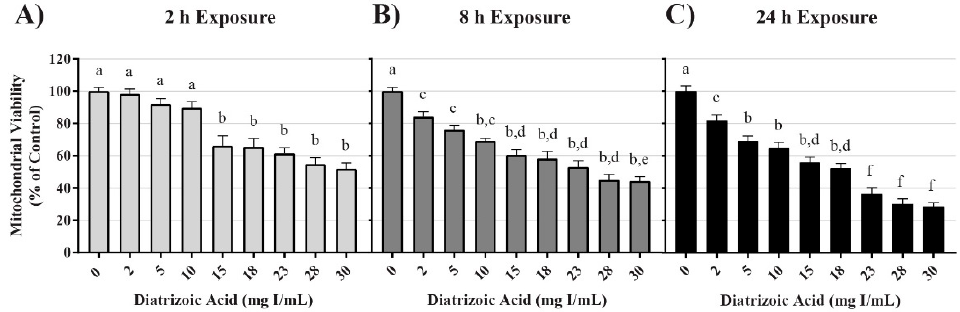
Figure 1. Diatrizoic acid cytotoxic effects on mitochondrial viability in HK-2 cells using 3-(4,5-dimethylthiazol-2-yl)-2,5-diphenyltetrazolium bromide (MTT). Diatrizoic acid (DA) diminished mitochondrial viability at 2 h ( A ), 8 h ( B ), and 24 h ( C ). Different letters (a–f) above each bar indicate statistical difference ( p < 0.05) between all treatments compared across all time points (2, 8, and 24 h). Values represent mean ± SEM for three independent experiments.